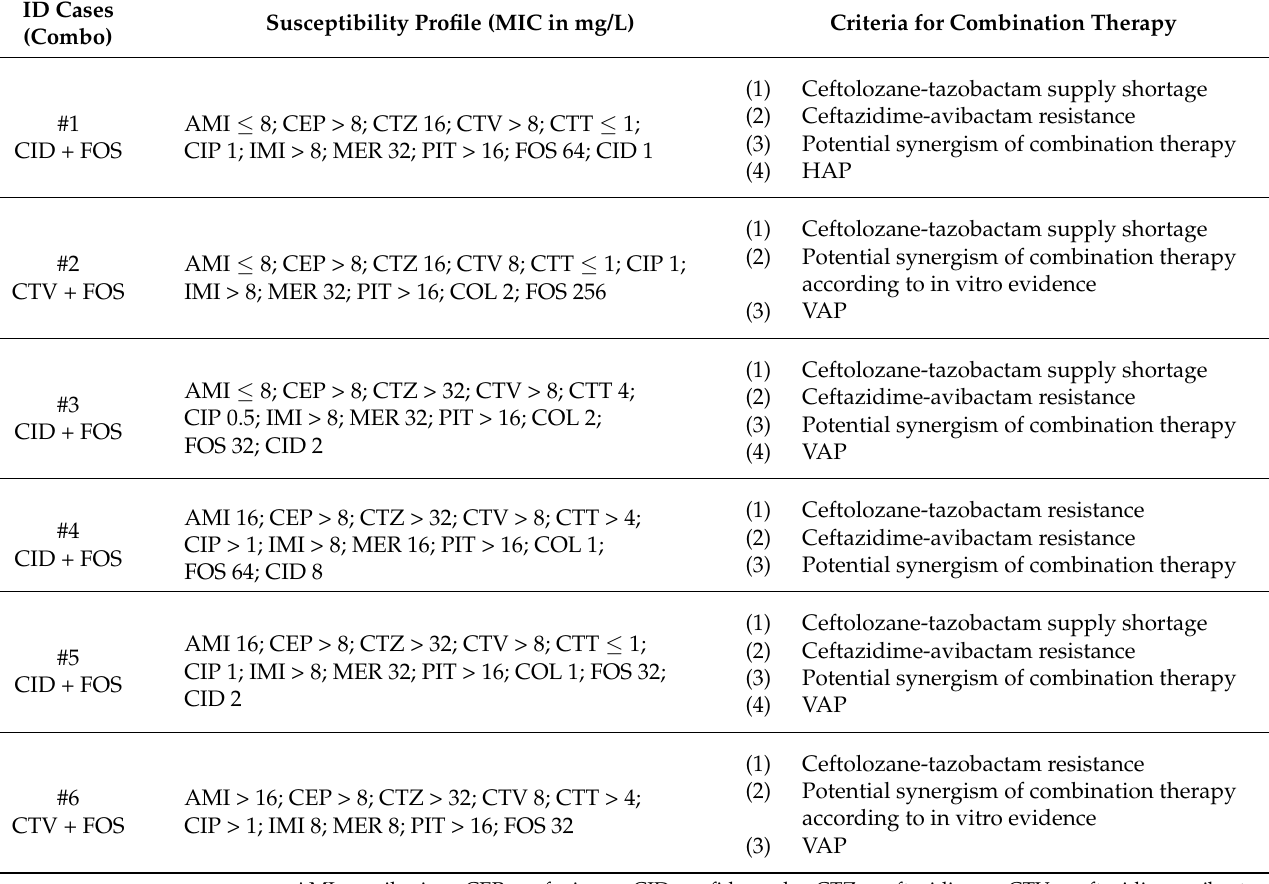
Table 2. Susceptibility profile of each DTR-PA clinical isolate and rationales for selecting combina- tion